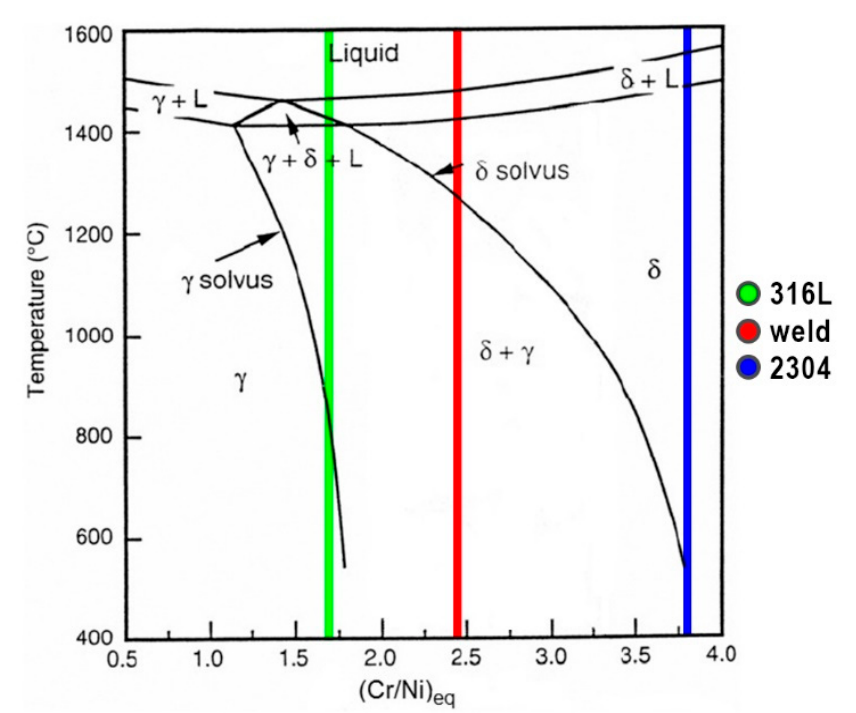
Figure 12. Fe-Ni-Cr pseudo-binary phase Figure 12. Fe ‐ Ni ‐ Cr pseudo ‐ binary phase diagram.